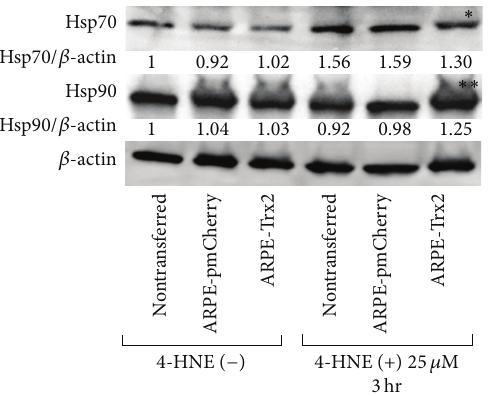
Figure 5: Western blot analysis of heat shock proteins expressed by cells under oxidative stress. Cells were exposed to 4-HNE for 3 hours. Untreated cells served as controls. The same blots were reprobed with an anti- 𝛽 -actin antibody to serve as loading controls. Hsp70 ( ∗ ) or Hsp 90 ( ∗∗ ) expression in ARPE-Trx2 cells was compared with that of untransfected or ARPE-pmCherry cells that were exposed to 4-HNE for 3 hours. Densitometric analysis of these proteins was performed using Quantity One software. The value relative to 𝛽 -actin of untreated cells is defined as